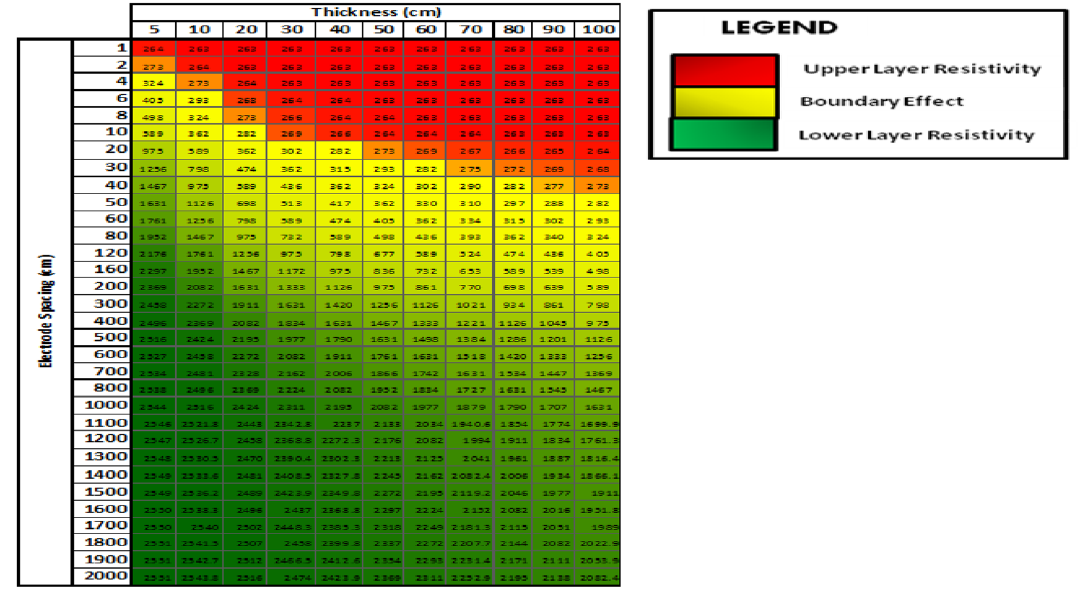
Fig. 7 Layer sensitivity model for typical field data